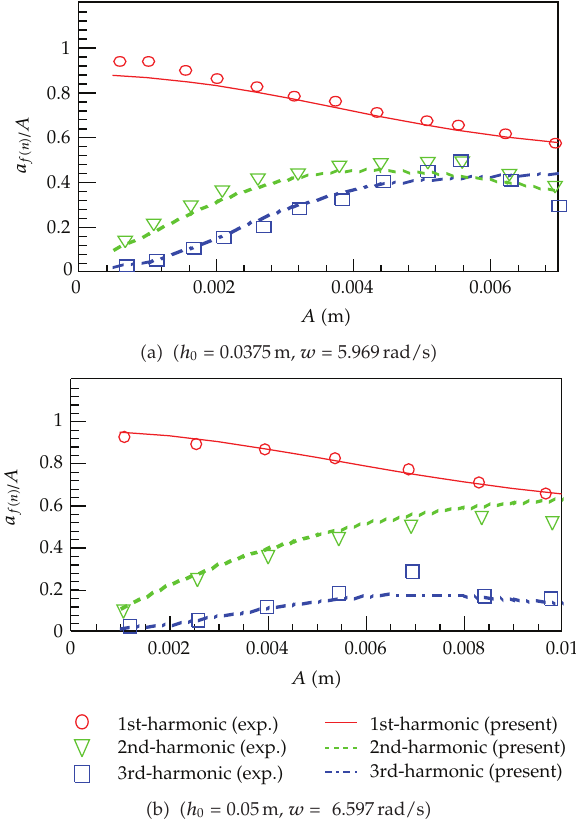
Figure 10: Distribution of higher free harmonic wave amplitudes with incident wave